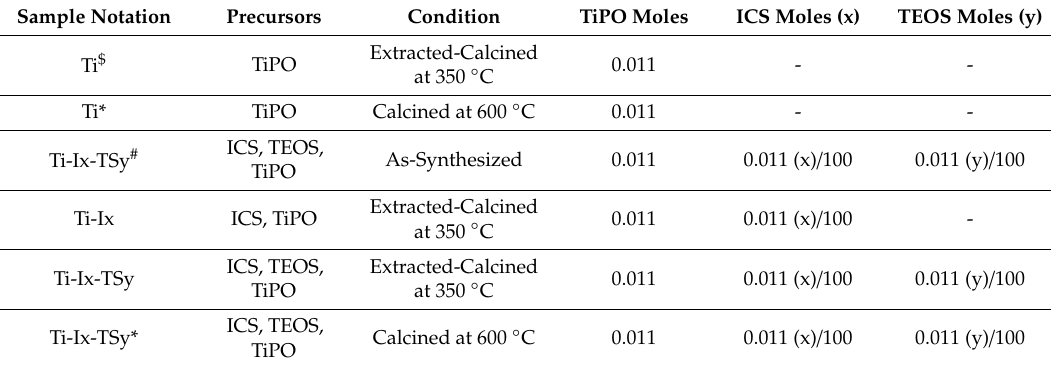
Table 1. Summary of the notations, precursors, and conditions of the synthesized